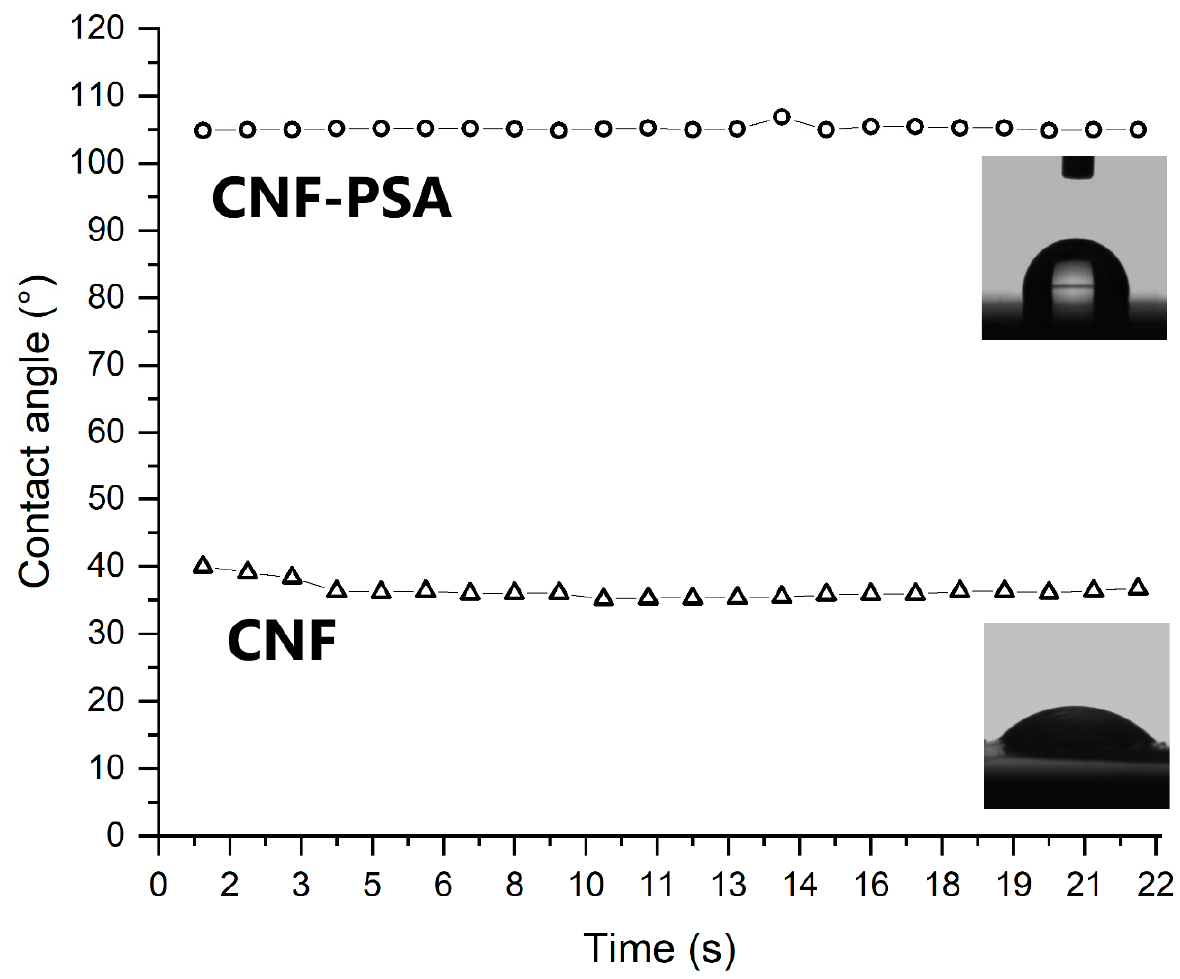
Figure 3. Photographs of the static contact angle measurements of water on unmodified CNF and CNF-PSA films, and the evolution of the contact angle against time. The CNF-PSA film has a contact angle of 105 ◦ , while unmodified film has a 36 ◦ contact